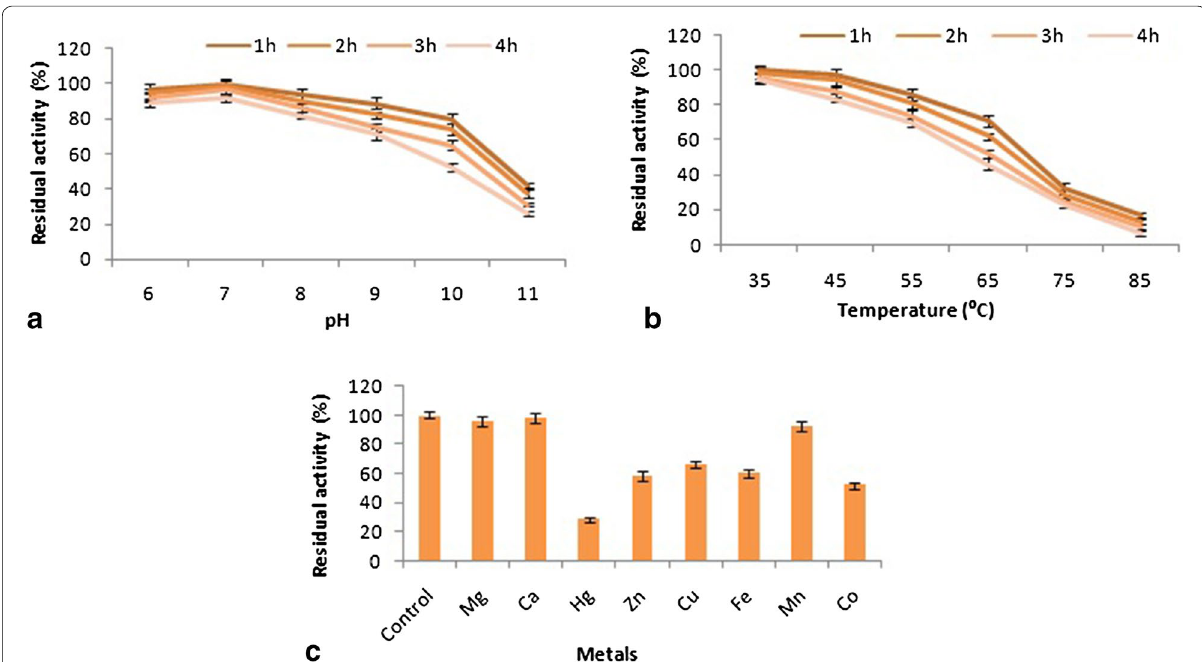
Fig. 4 Effect of a pH, b temperature, and c various metal ions on the stability of amylases. Values represent mean